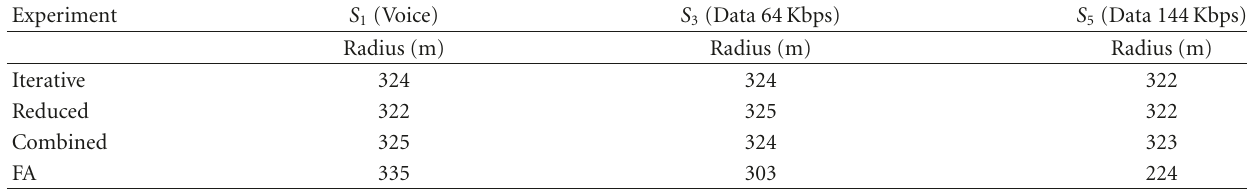
Table 7: Cell radius (in metres) for the di ff erent services in Experiment 3.